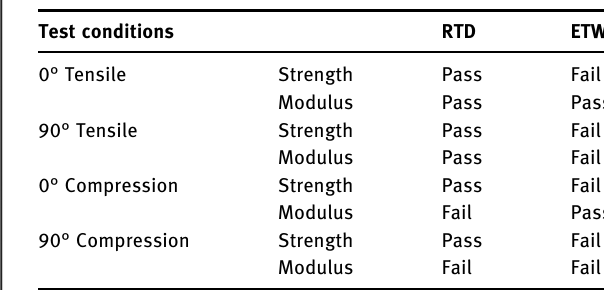
Table 2: Results of the fi rst equivalency test applying the Case 1